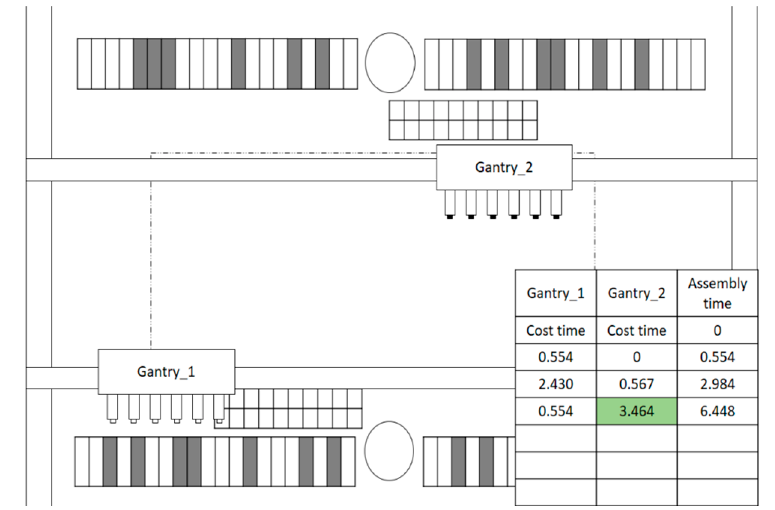
Figure 21. Gantry_1 is picking, and Gantry_2 is placing components.